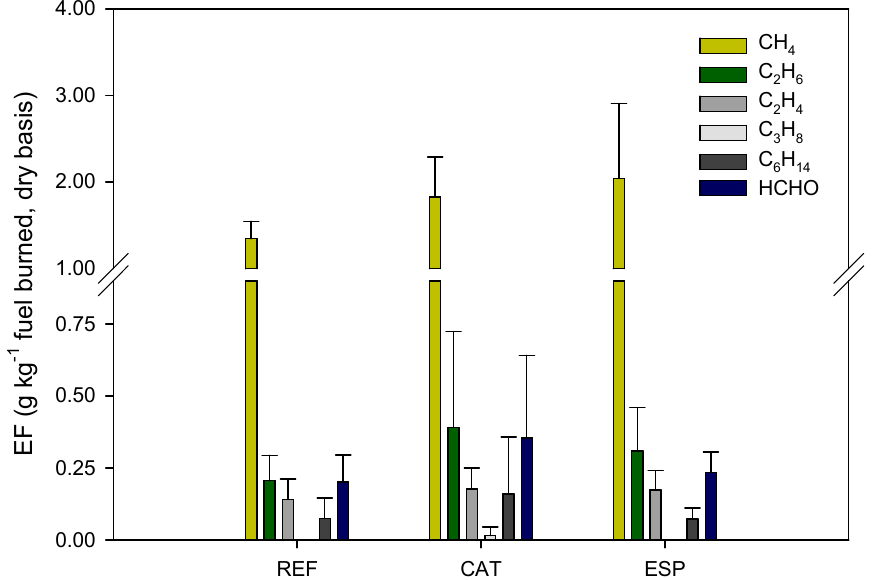
Figure 3. Emission factors of the individual hydrocarbons (CH 4 , C 2 H 6 , C 2 H 4 , C 3 H 8 , C 6 H 14 , and HCHO) from pine wood combustion with or without catalytic converter (CAT) and electrostatic precipitator (ESP). Asterisks indicate a statistically significant difference compared to the reference condition (REF) ( p < 0.05; Kruskal–Wallis test).